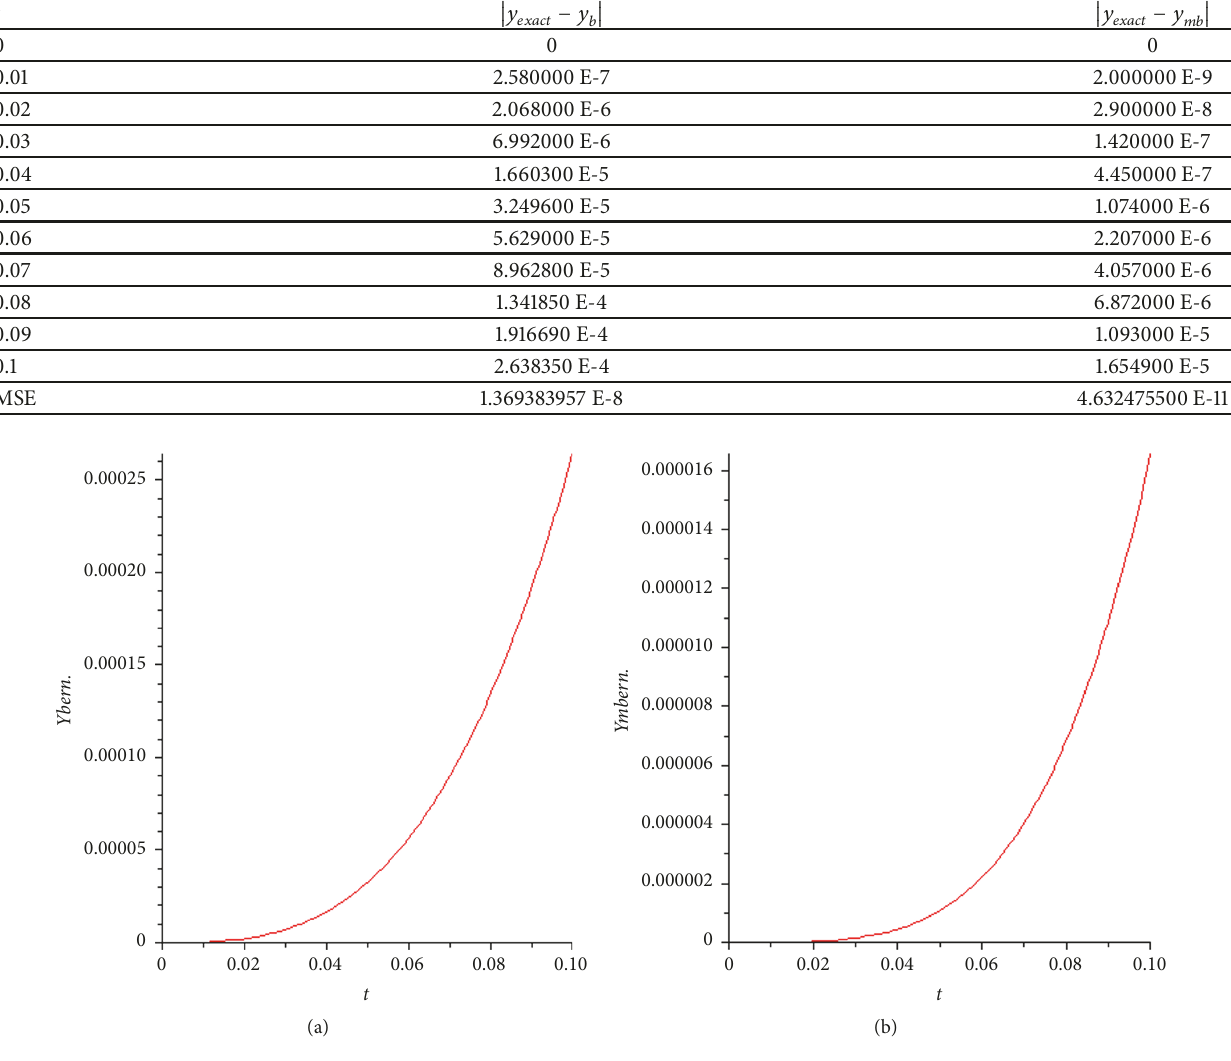
Figure 1: The absolute error between ADM with modified Bernstein polynomials and the exact solution when m=v=6 and k=2.